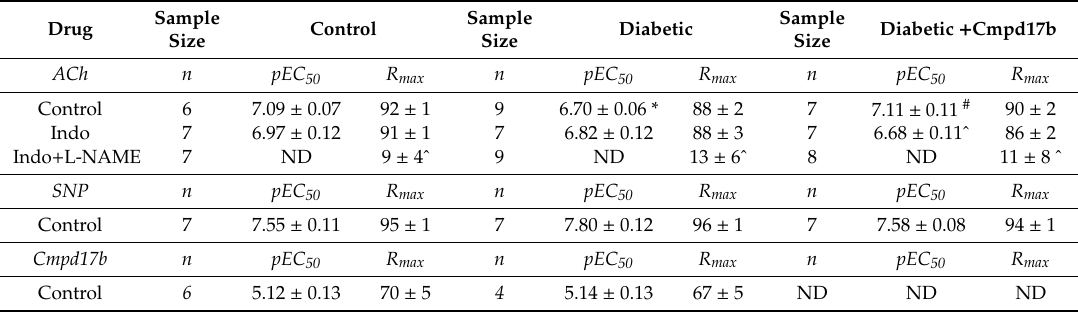
Values are expressed as mean ± S.E.M; n , aorta from individual mice. ACh, acetylcholine; Indo, indomethacin; L-NAME, N ω -nitro-L-arginine methyl ester; SNP, sodium nitroprusside; pEC 50 , sensitivity; R max , maximum relaxation. ND = not determined. * Significantly di ff erent from control treated group; # significantly di ff erent from diabetic group; ˆ R max significantly di ff erent from control and Indo incubated aorta within the same treatment